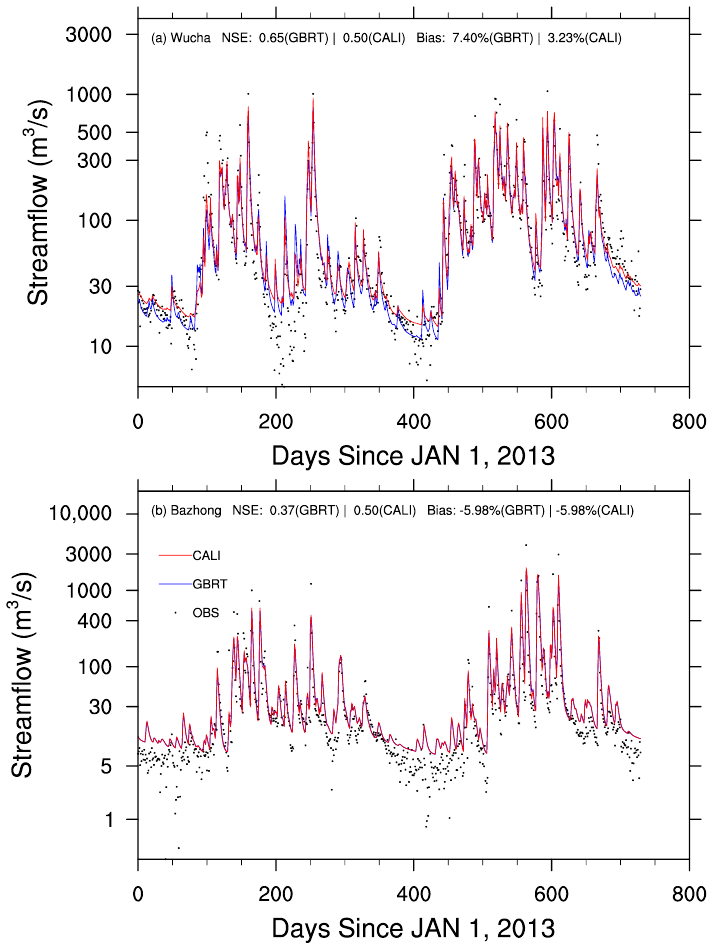
Figure 10. Comparison of observed streamflow and XAJ-simulated streamflow using calibrated CS (red) and GBRT-estimated CS (blue), respectively, in Wucha and Bazhong catchments (note the Y axis is